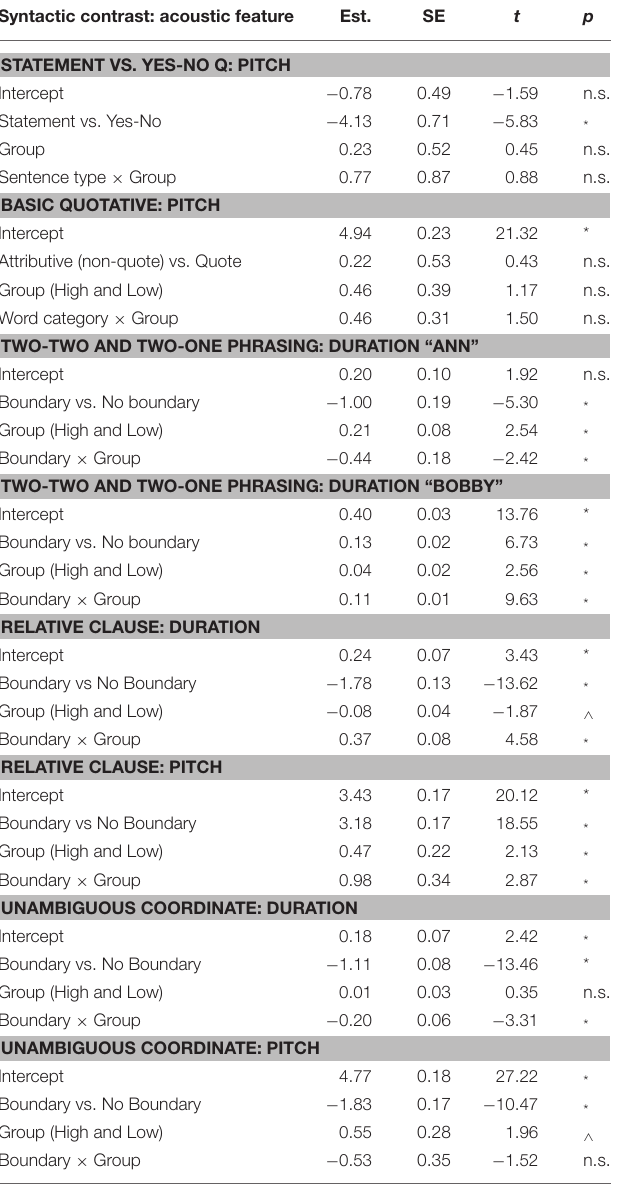
TABLE 4 | Parameter estimates of regression models.